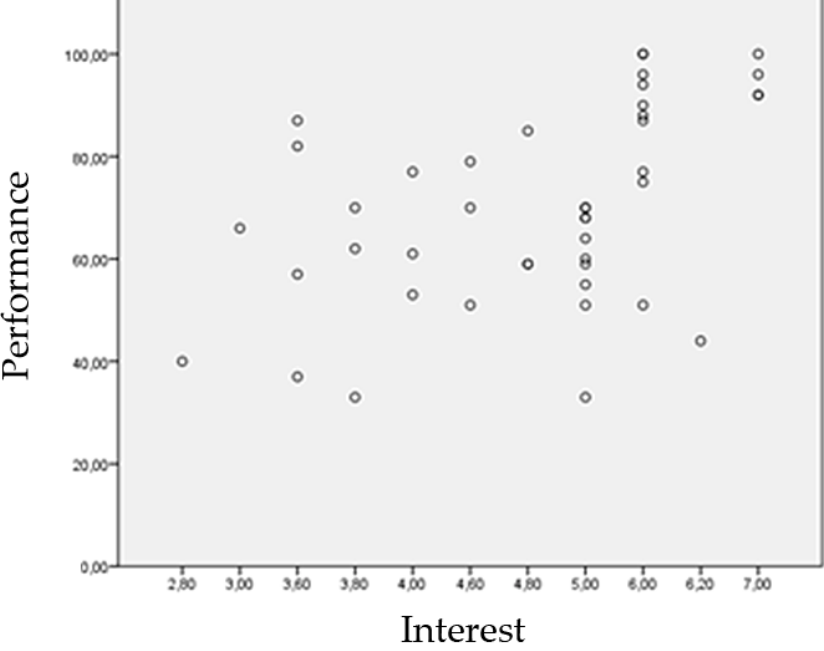
Figure 6. Correlation between interest and performance.